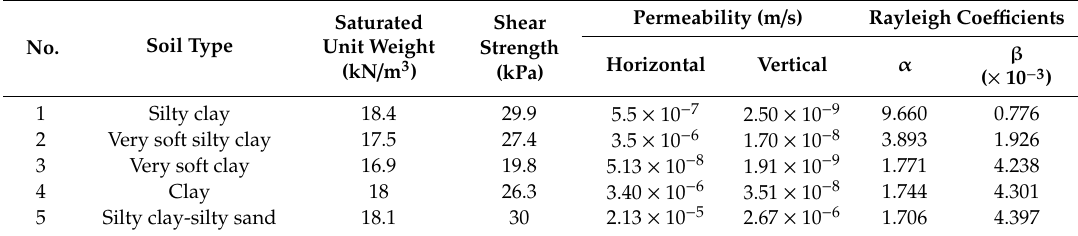
Figure 2. ( a – c ) Soil-Tunnel geometry: ( a ) Soil layers with the embedded triple tunnel complex. ( b ) Soil column w.r.t depth and type. ( c ) Enlarged triple tunnel complex section, also showing the truncated parts (units in ‘m’). ( d ) Shear wave velocity profile w.r.t depth. Table 1. Soil properties used in the study.